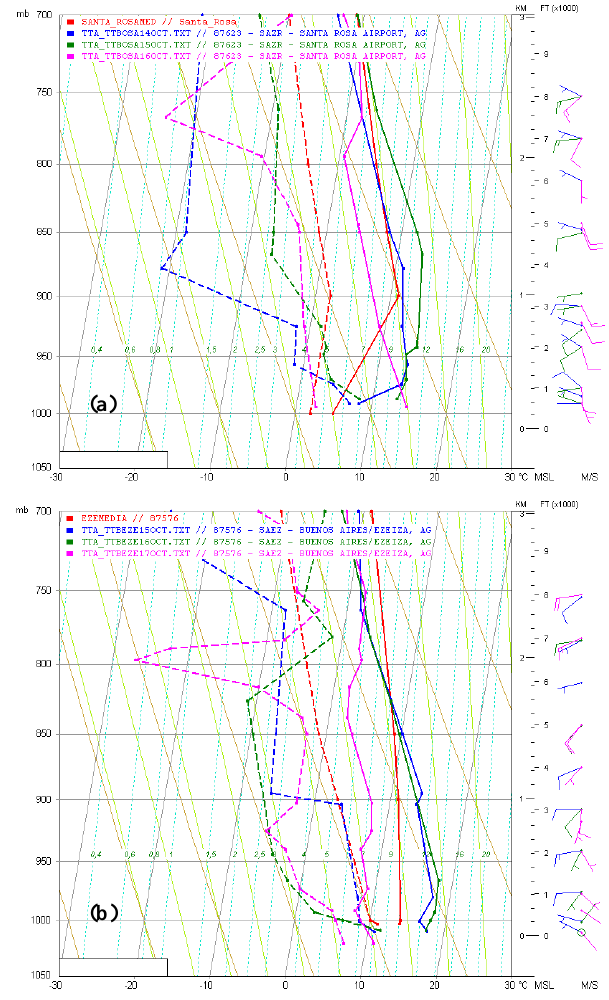
Figure 2. Thermodynamic profiles at 12:00UTC over (a) Santa Rosa and (b) Ezeiza: wind (in ms − 1 , barbs) and temperatures (in ◦ C; air temperature is the solid line and dew point temperature is the dotted line). The red curves are the mean decadal soundings ob- tained by Velasco and Necco